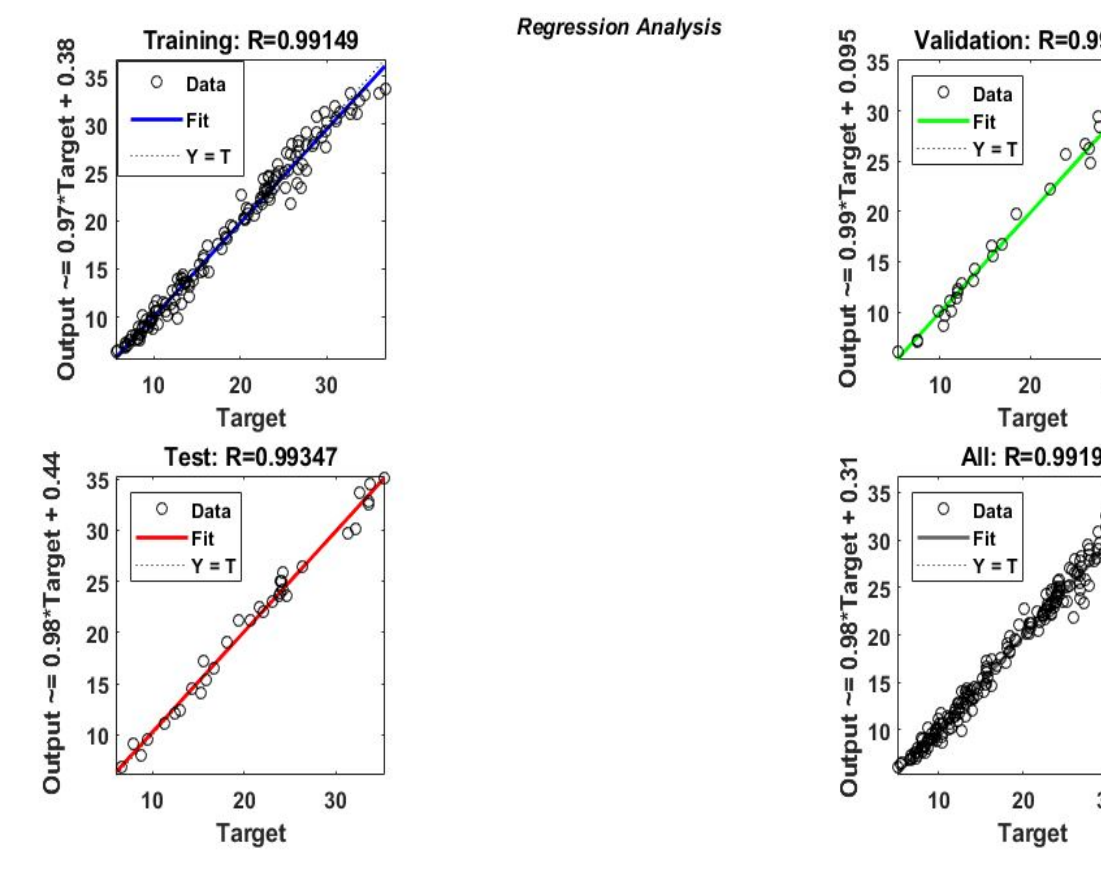
Figure 5. ANN training flow sheet.